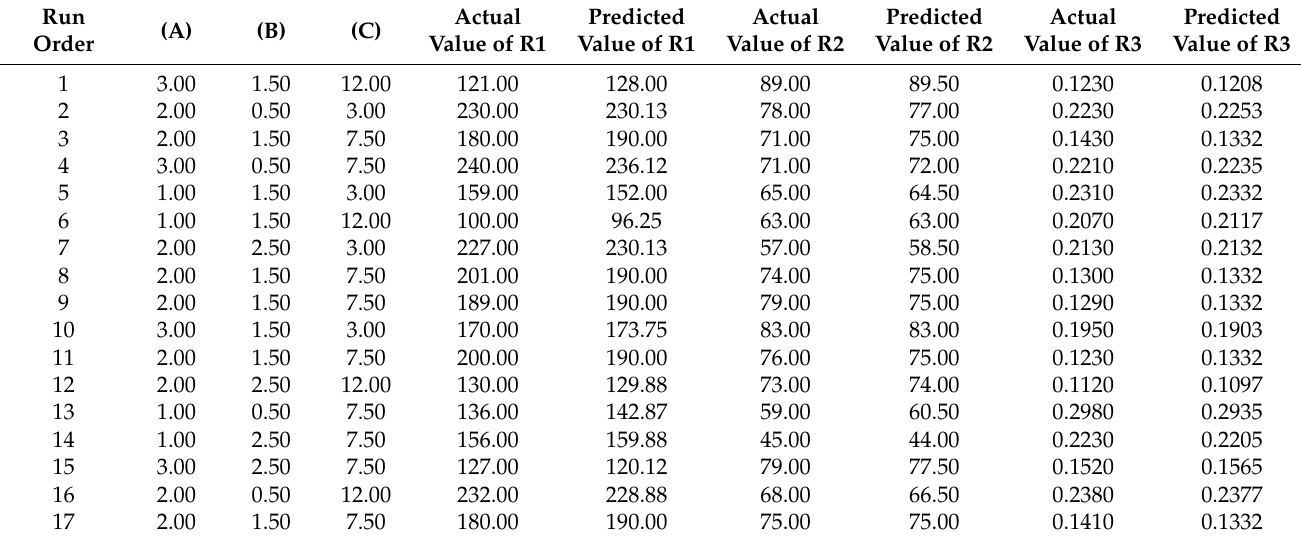
Table 2. Observed responses in Box–Behnken design for Dox–Erlo NP preparations with their predicted and actual